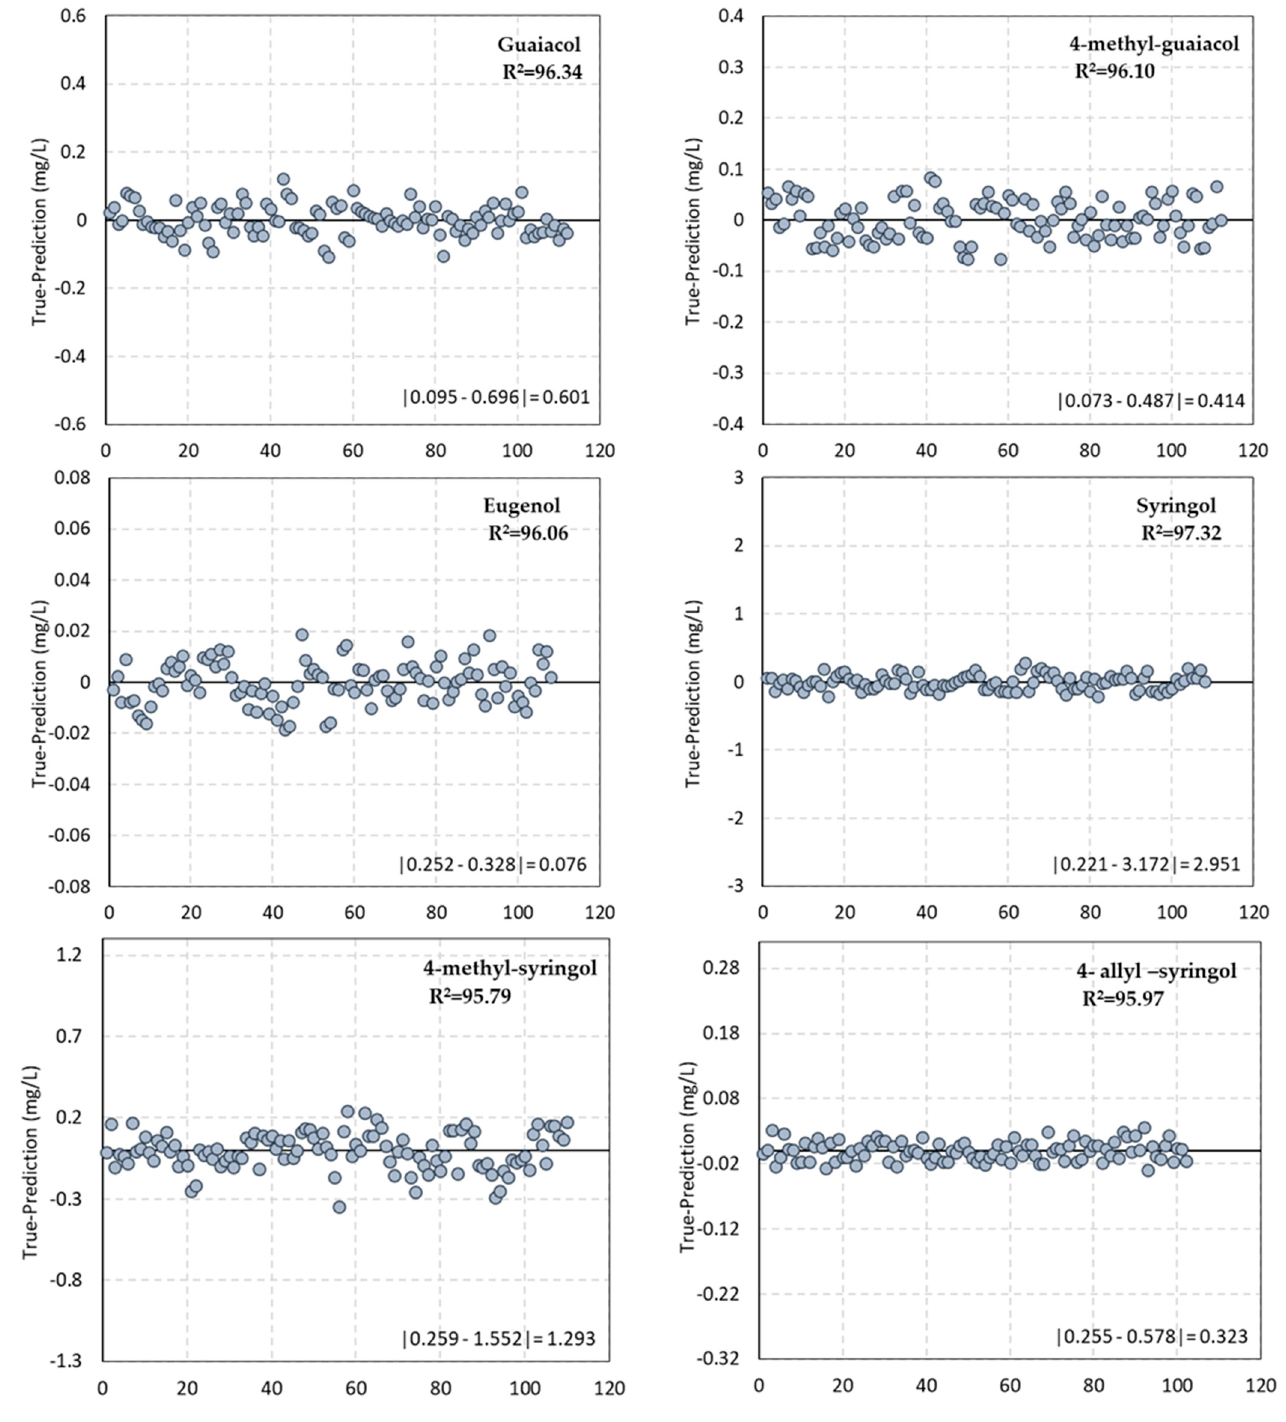
Figure 5. True value − Prediction value of each volatile compound analysed compared to the difference between the minimum and maximum a value.